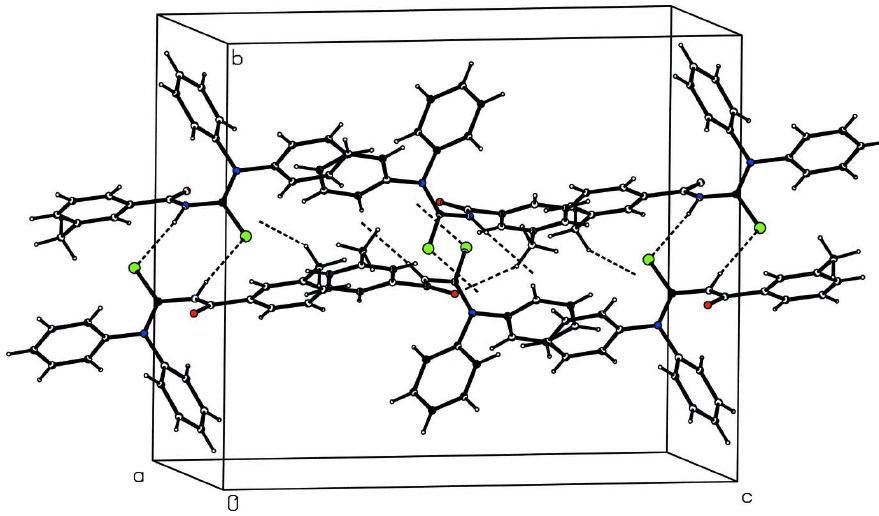
Figure 2 A packing diagram for (I). Hydrogen bonds are shown as dashed